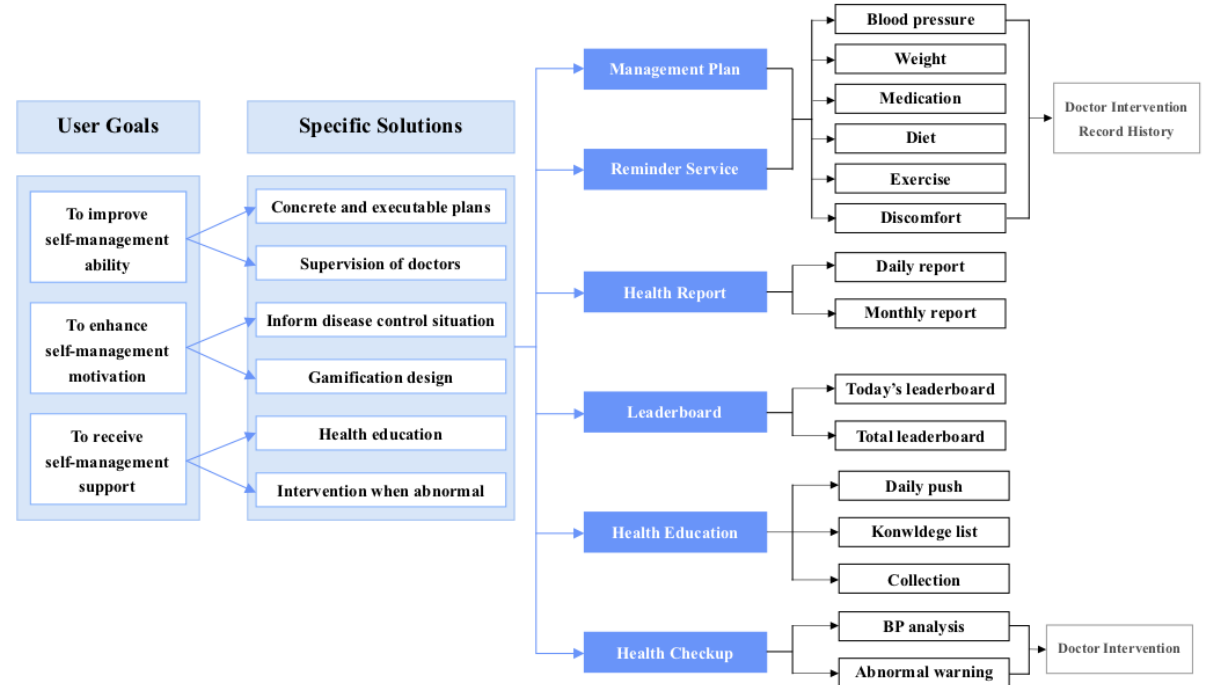
Figure 8. Complete requirements analysis process.